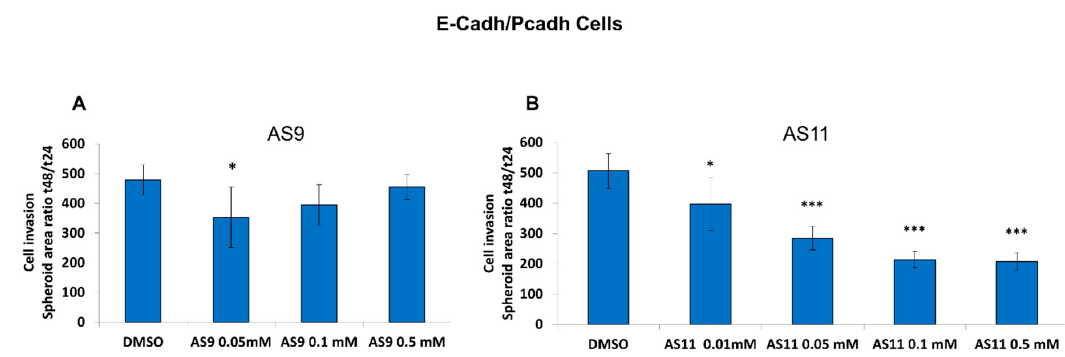
Figure 8. AS11, but not AS9, regulates cell invasion. BxPC-3 E-cadh/P-cadh cells (no cadherin depletion), BxPC-3 E-cadh cells (P-cadherin depletion), and BxPC-3 P-cadh cells (E-cadherin depletion) were allowed to form spheroids for 72 h. Spheroids were then embedded in type I collagen. After embedding, followed by a 24 h incubation in the presence of either 0.2% DMSO or 0.1 mM AS9 or AS11, the spheroid area was observed by phase contrast microscopy ( A ). Scale Bar: 500 μ m. ( B ): the spheroid area was measured using ImageJ. Results are expressed as the percentage of invasion of treated cells compared to control cells.